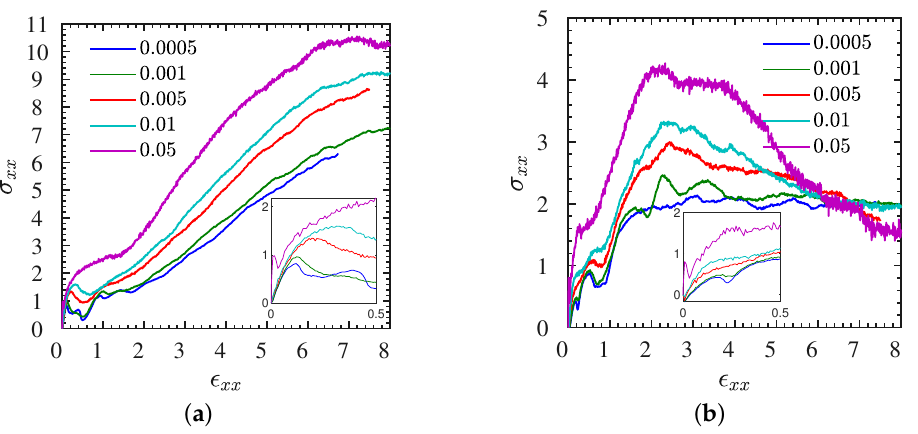
Figure 2. Rate-dependence of stress–strain curves for ( a ) entangled L1 • , and ( b ) unentangled S1 • at an NP loading of φ = 11.6%, and ε r = 24. Different rates are marked by different colors, from ˙ ε xx = 0.0005 (blue) to ˙ ε xx = 0.05 (purple). Insets provide zooms into the regions of moderate strains below 50%.